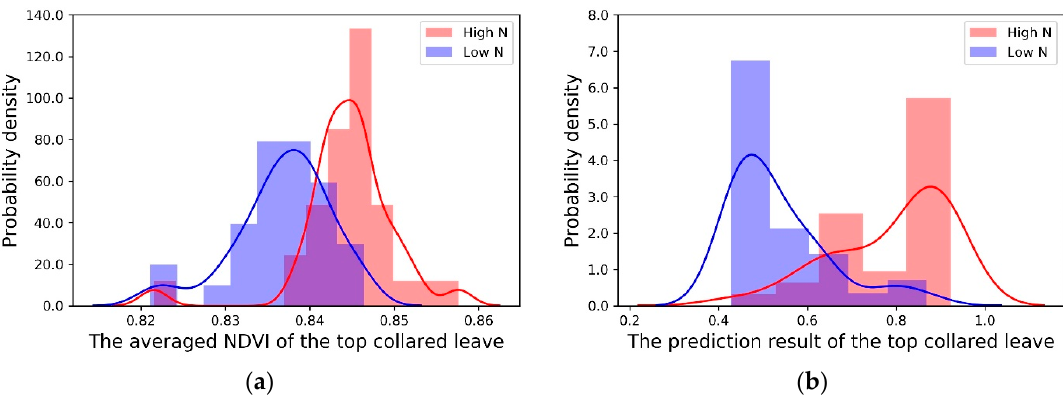
Figure 6. The probability density distribution (PDE) of top-collared leaves for different nitrogen treatments: High N (red); Low N (blue). ( a ) The PDE of the averaged NDVI. ( b ) The PDE of the prediction results from the Random Forest algorithm.